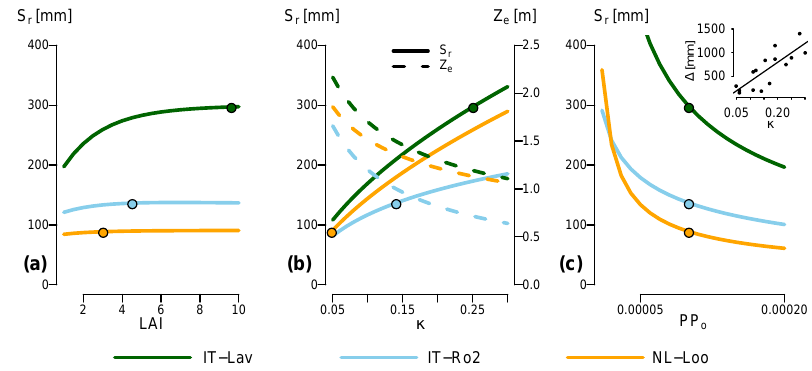
Figure 7. Effect of three parameters on G-For10 predictions of S r , for three contrasting sites. All other parameters are set to their standard or site-specific value. The dots show the S r estimates obtained with standard configuration (Table 2). (a) Change in S r as a function of LAI. As LAI increases, so does the contribution of the overstory to total S r . Due to the differences in parameterization (Table 1) and water uptake model, the rooting depth for the overstory is always greater than for the understory. This effect is greatest at mesic sites with high soil water holding capacity, such as Lavarone. (b) Change in S r (solid lines) and overstory effective rooting depth Z e (dashed lines) as a function of soil water holding capacity κ . While an increase in κ leads to shallower roots (decreasing Z e ) , the effect on S r is inverse (increasing S r ). (c) Change in S r as a function of the parameter PP o , which summarizes vegetation properties. The sensitivity of S r to PP o varies greatly among the sites, as, e.g., halving the standard value of 0.0001 leads to an increase in S r of 50mm at Loobos and Roccarespampani, and over 100mm at Lavarone. The inset shows the relationship between κ and the difference between S r calculated at PP o = 0 . 00005 and PP o = 0 . 0002 ( R 2 = 0 . 66, p = 0 .